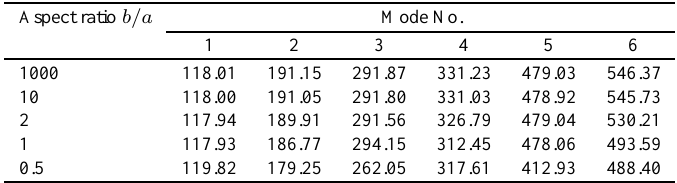
Table 4 Natural frequencies (in Hz) of Simply-Supported elliptical cross-section beam